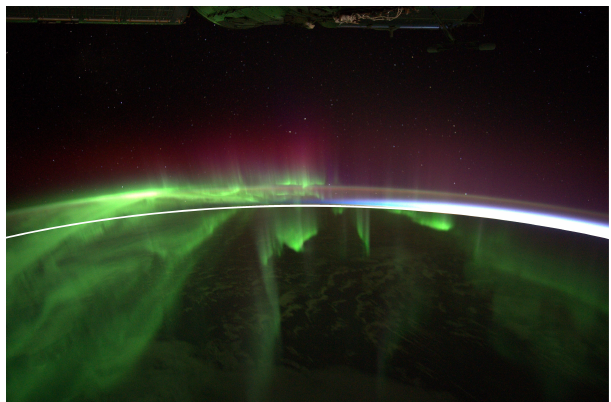
Figure 9. As in Fig. 8 but with the timestamps corrected by 25s. The horizon now matches its expected position much more